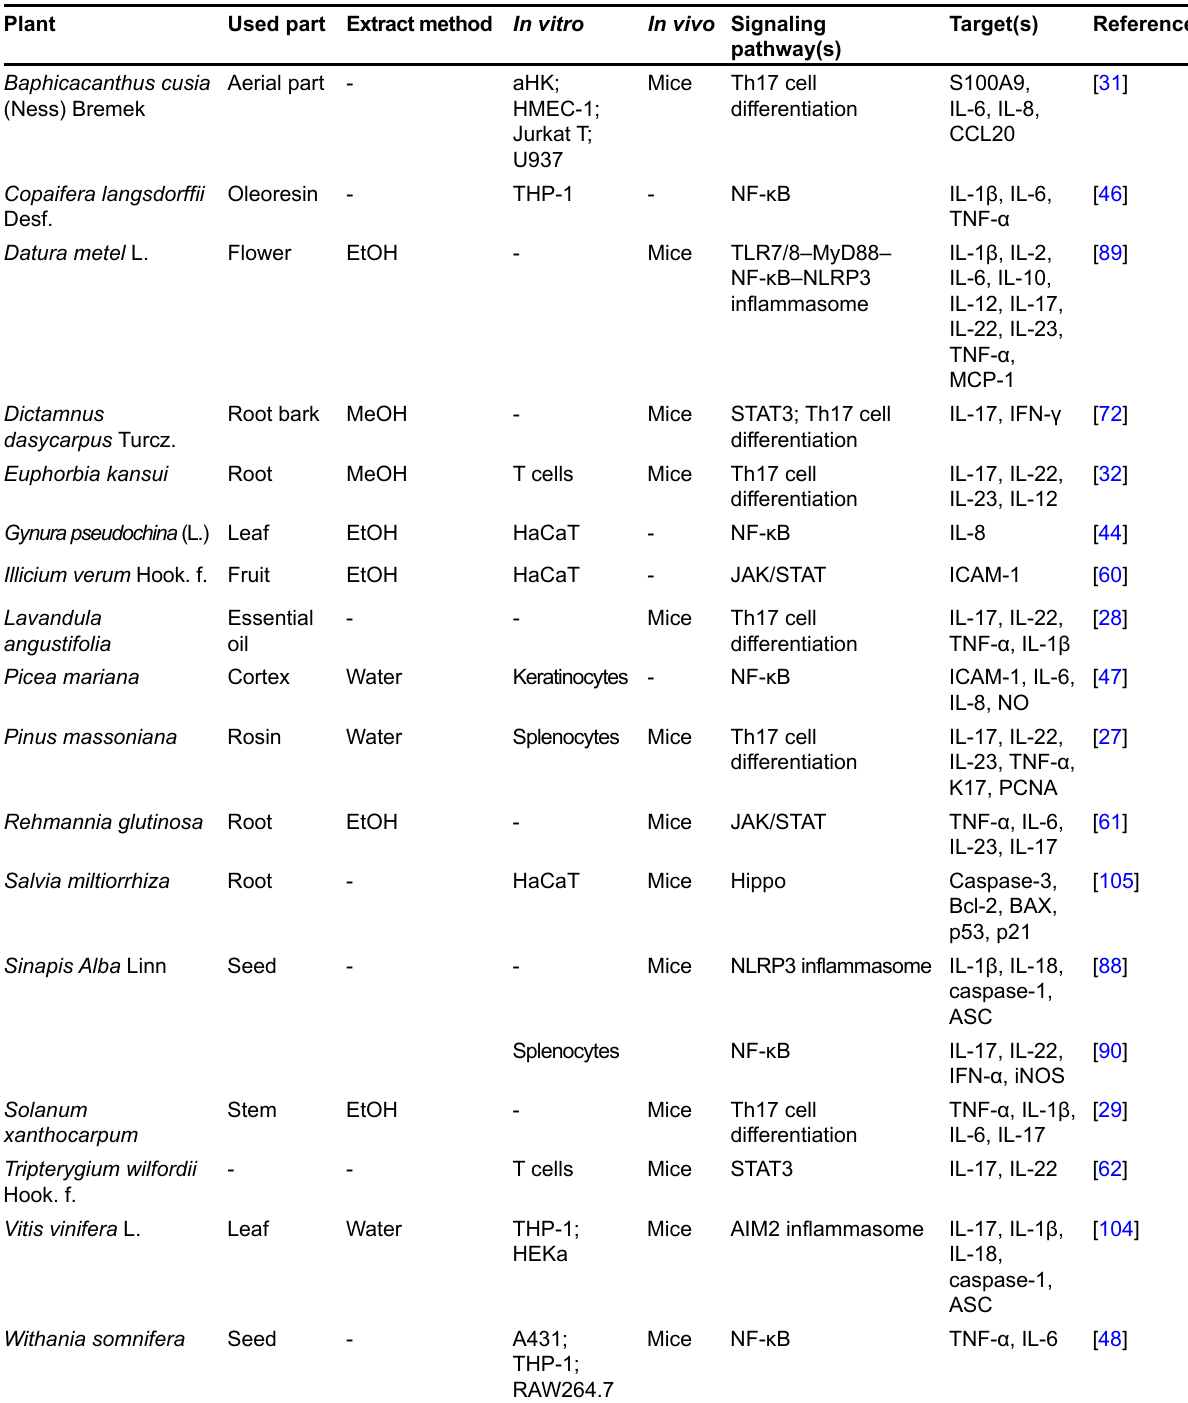
Table 1. The effects of extracts on psoriasis ( continued )